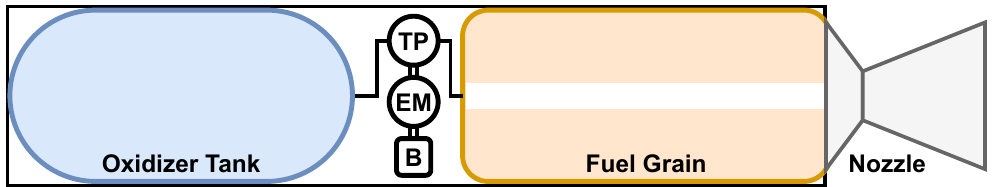
Figure 1. Conceptual scheme of the hybrid rocket engine design: TP stands for turbo-pump, EM stands for electric motor and B stands for battery (not to